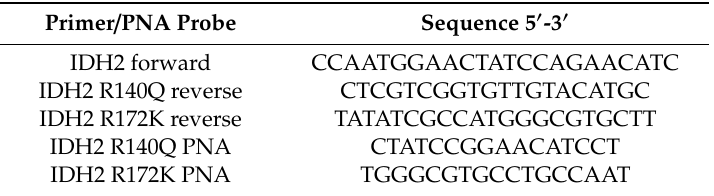
Table 1. Primers and PNA probes sequences for PNA-PCR